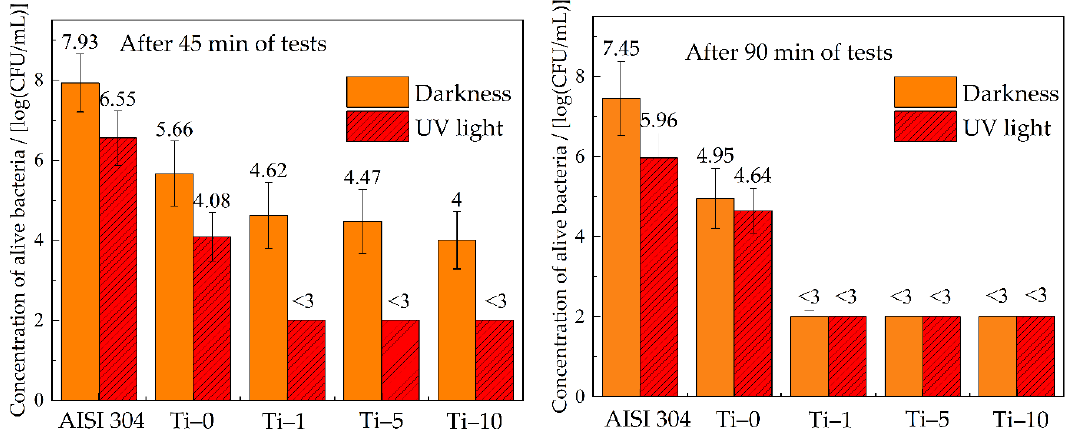
Figure 9. Antibacterial properties of obtained coatings towards E. coli ATCC 8739.